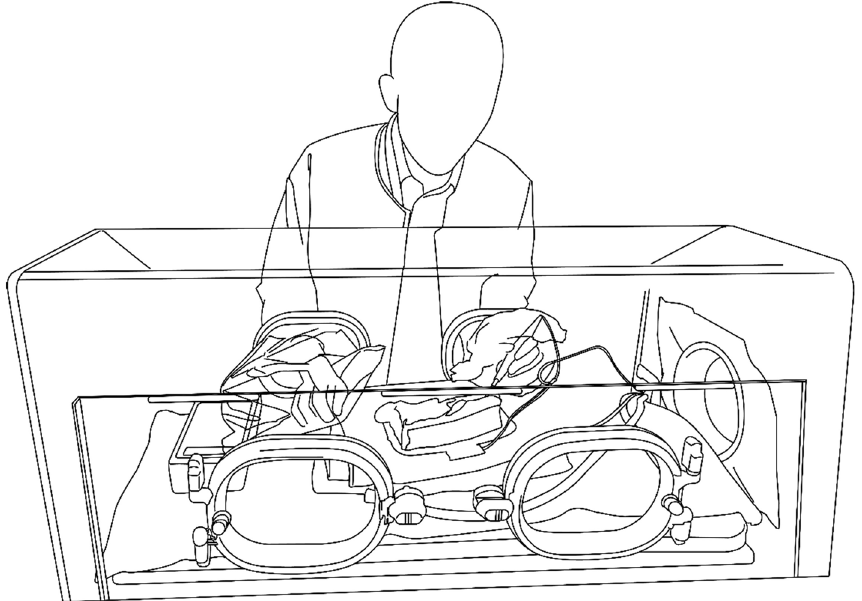
Figure 1. The setting of experiment. Porcine tissue was placed at the center of a closed room (Infant Incubator ATOM V-2100G). We used MET ONE AEROCET 831 (placed on the right side) to measure surgical smoke with different aerodynamic equivalent diameters (AEDs) of particle matter (less than 1 μm, 1–2.5 μm, 2.5–4 μm, 4–10 μm, larger than 10 μm and TSP). The authors thank Cheng-Han, Li for this